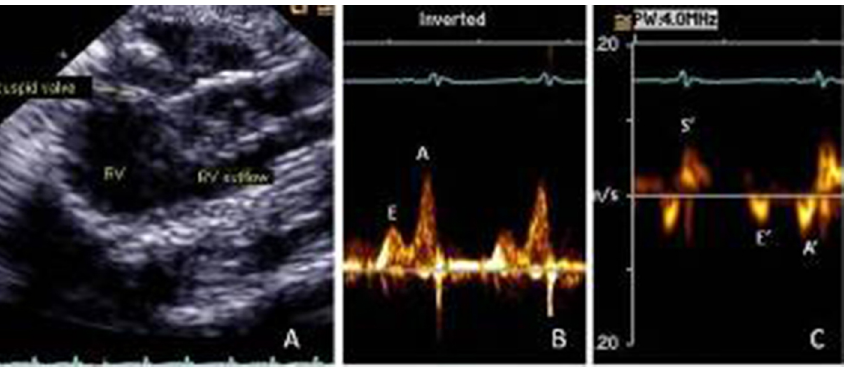
Figure 1. Transesophageal echocardiography of spontaneously hypertensive rats showing right ventricle (RV) (A), tricuspid inflow (B) and tissue Doppler imaging of the tricuspid annulus